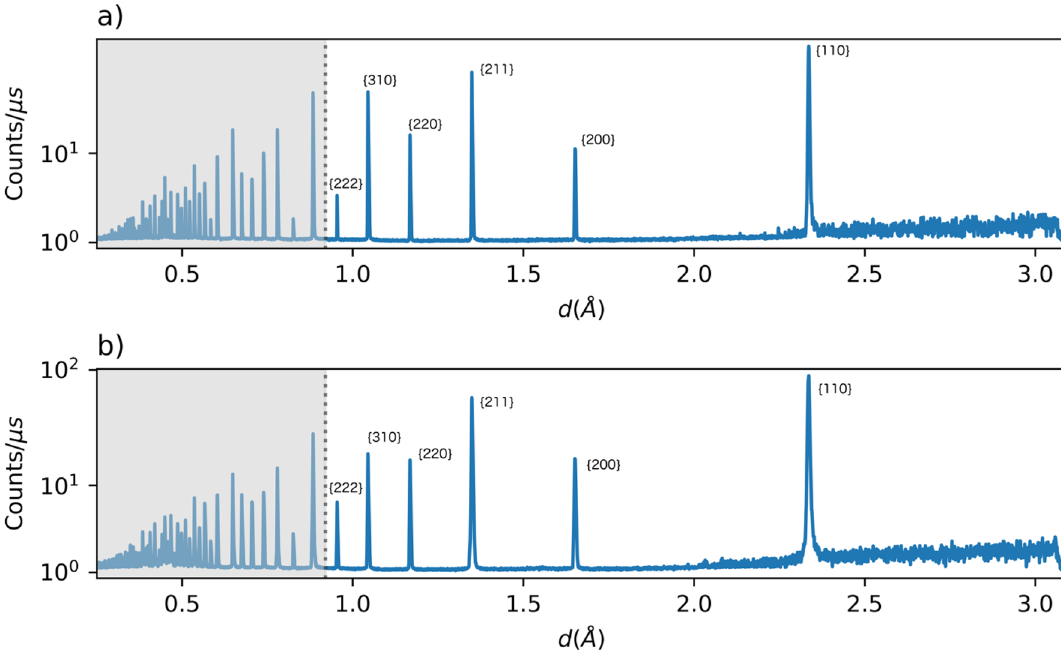
Figure 10. Neutron diffraction profiles measured for IP1.8 ( a ) and IP30 ( b ) are shown. The first six peaks are labelled with the hkl of the diffraction plane. The portion of the profile not used in the analysis is greyed out.